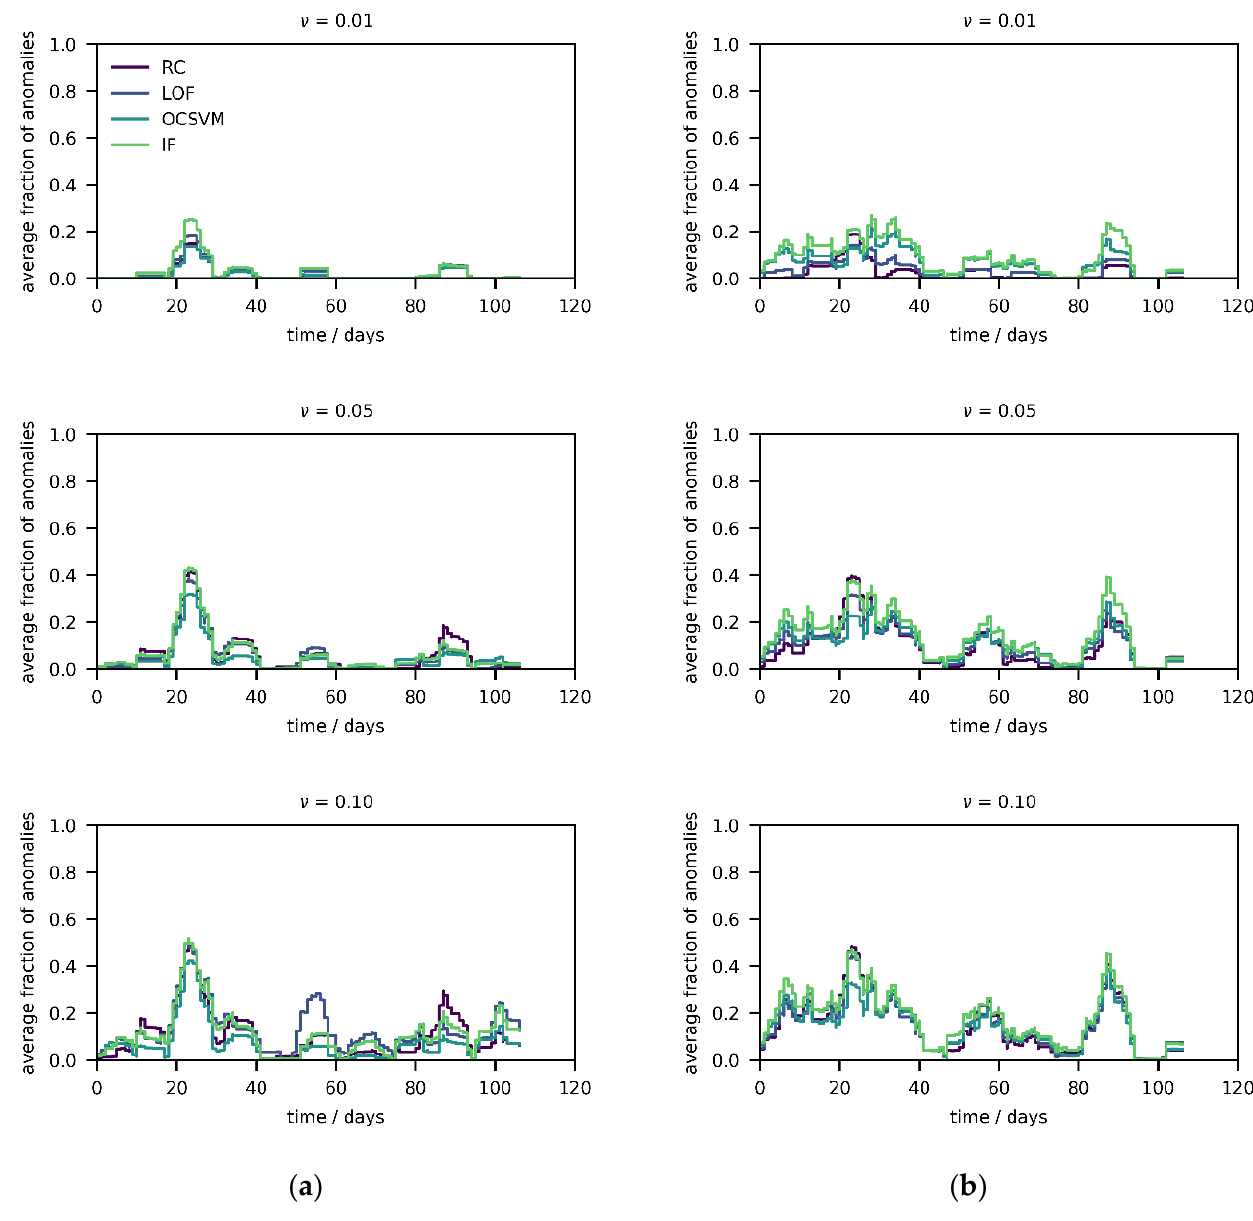
Figure 2. ( a ) Fraction of anomalies (weekly moving average) over four months for different ν across algorithms after two weeks of field calibration for sensor data of device 1. ( b ) Fraction of anomalies (weekly moving average) over four months for different ν across algorithms after two weeks of field calibration for reference data. Table 2. Summary statistics (quantiles) of calibration distribution inside envelope and monitoring distribution outside